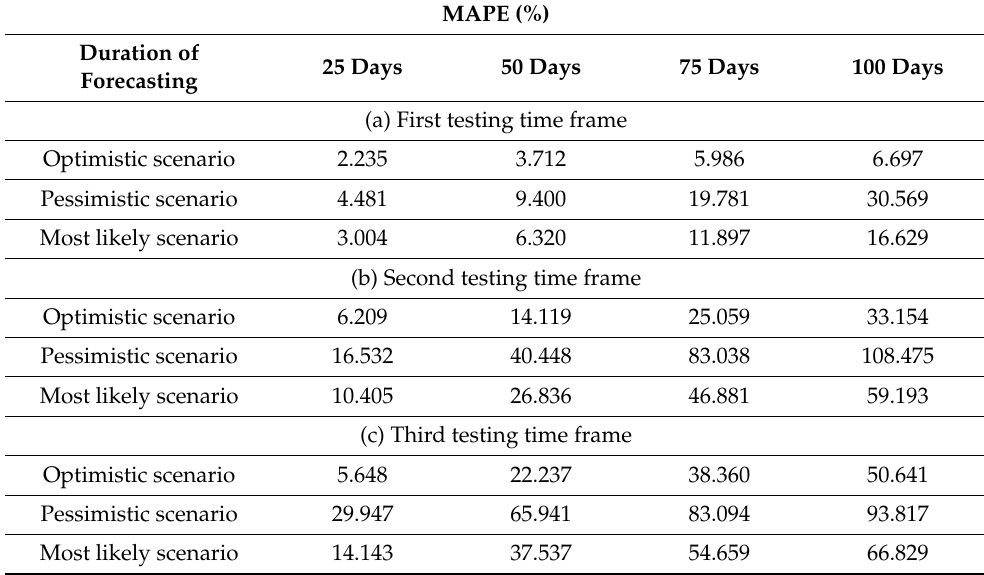
Table 2. Forecasting accuracy (MAPE%) depending on the duration of the time